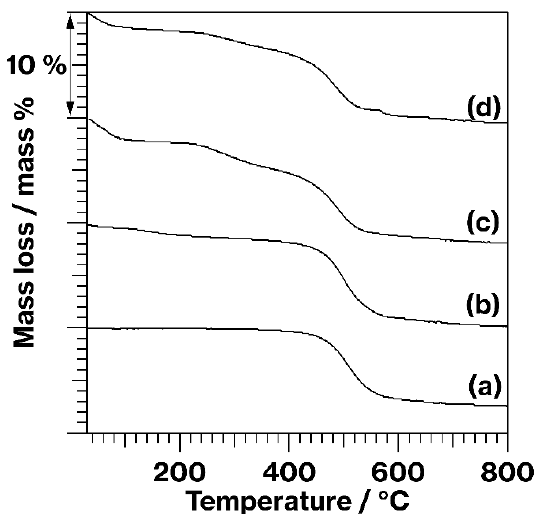
Figure 4. TG curves obtained from (a) kaolinite, (b) MeO-Kaol, (c) C18TAC/MeO-Kaol_Wash, and (d) C18TAB/MeO-Kaol_Wash. (d)